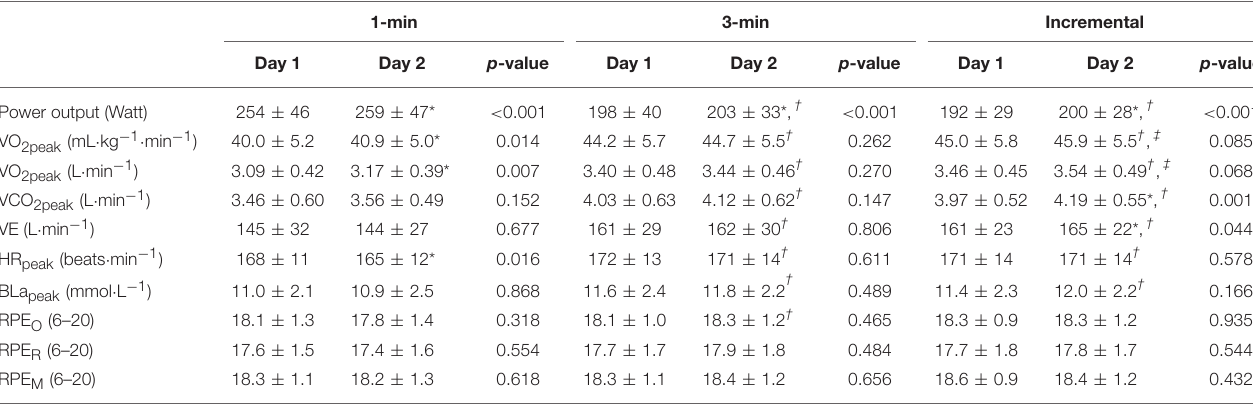
Calculations are based on data from 22 participants for the 1-min and the incremental test and 24 participants for the 3-min test. Peak oxygen uptake (VO 2 peak ), peak carbon dioxide production (VCO 2 peak ), minute ventilation (VE), peak heart rate (HR peak ), peak blood lactate (BLa peak ), overall rate of